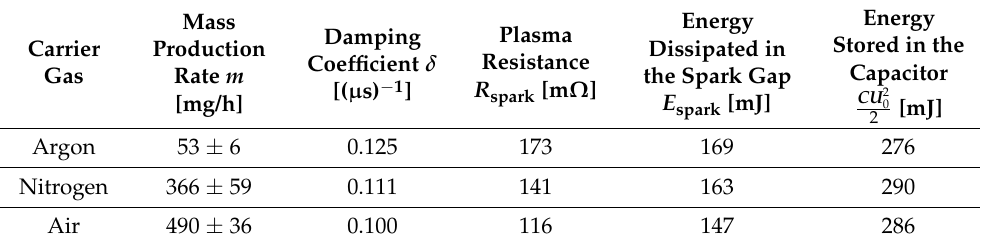
Table 1. Mass production rate, time and energy parameters of the spark discharge depending on the carrier